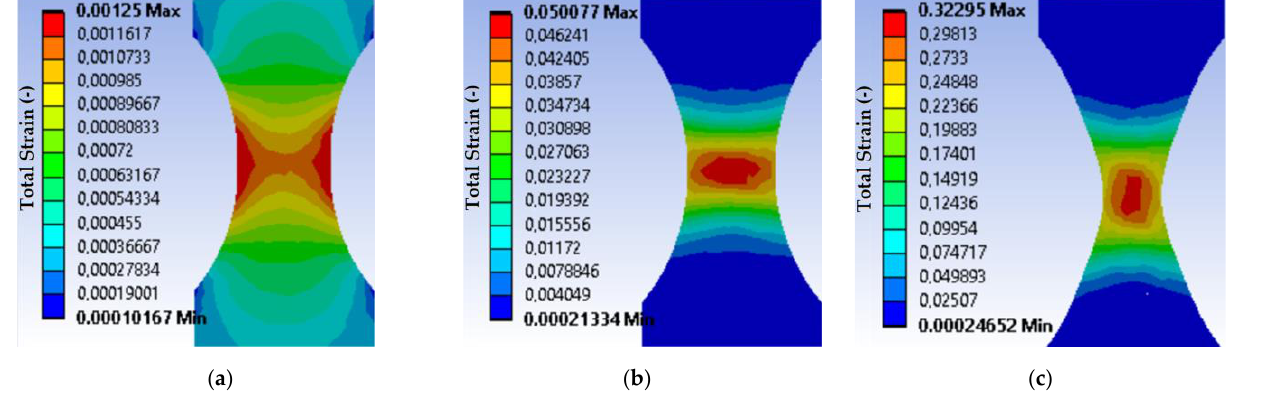
Figure 8. Total strain distribution in the sample during its loading under the load mode І : ( а ) when the equivalent stresses reach the yield strength; ( b ) when the equivalent stresses reach the ultimate strength; ( с ) at the fracture moment.